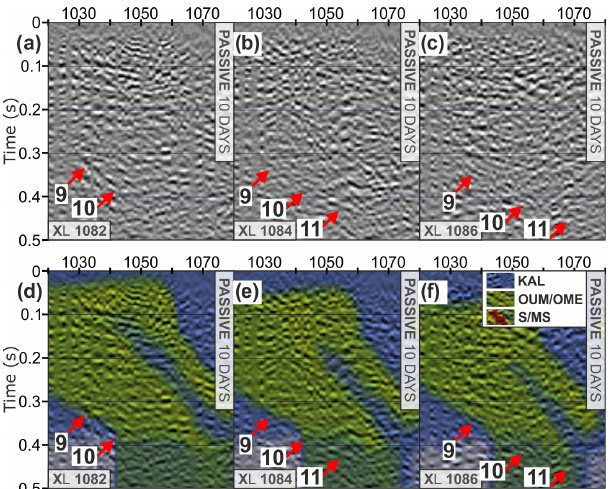
Figure 9. Comparison of post-stack migrated sections obtained from the 3D virtual-source survey along crosslines 1082 (a,d) , 1084 (b,d) , and 1086 (c,f) . Red arrows mark the reflection events that are associated with a key contact within the Kylylahti formation (OUM/OME in contact with black schists – KAL). Note that the extent of the geological model shown is constrained by the bore- hole data, and the marked reflections are at the very edge of this extent. The Kylylahti formation continues beyond the shown extent with further repetitions of the OUM/OME units with black schist interlayers. The arrows with numbers show reflections that are in- terpreted in the text. The geological model (described in Sect. 2) displayed in the background is color-coded as follows: S/MS min- eralization (red); OUM/OME units (green); KAL unit